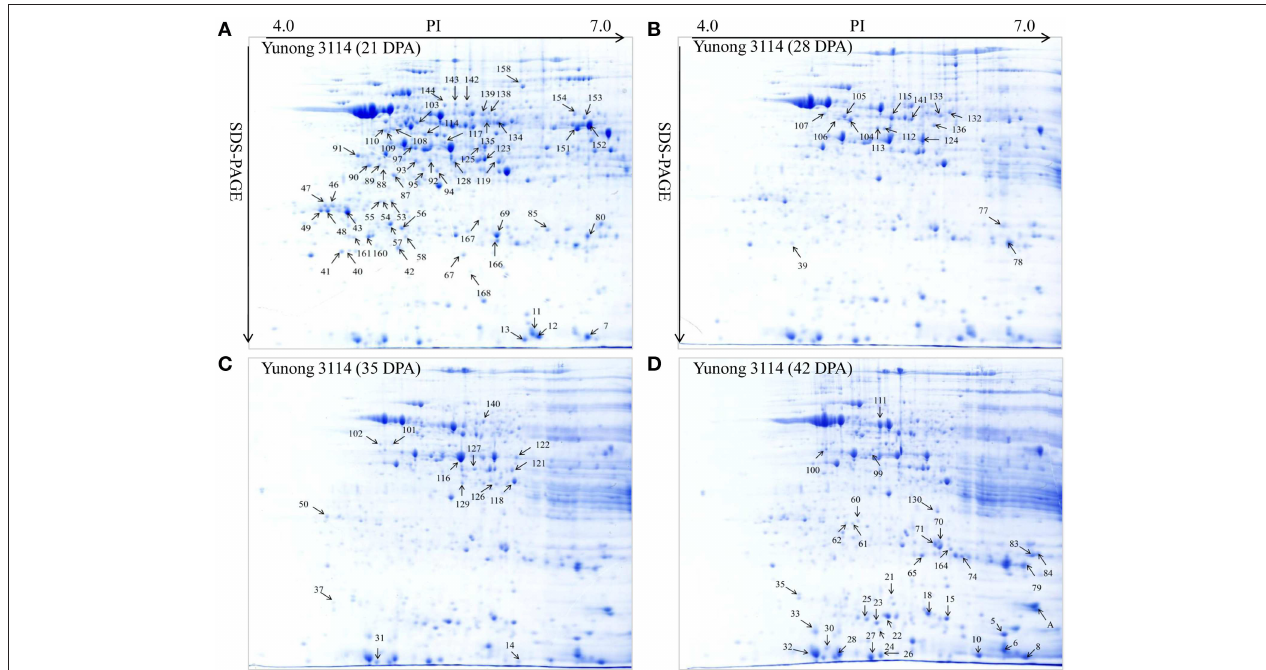
FIGURE 2 | Showing 2-DE maps of proteins extracted from the first sample of Yunong 3114. (A–D) 2-DE maps during four grain development stages for 21, 28, 35, and 42 DPA in Yunong 3114.